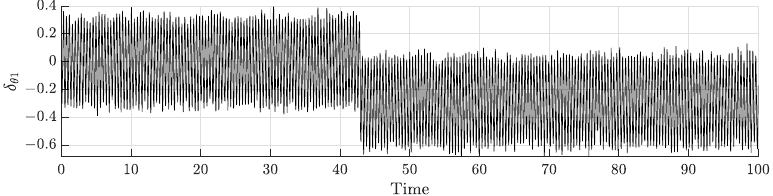
Figure 6. Uncertainties on agent 1